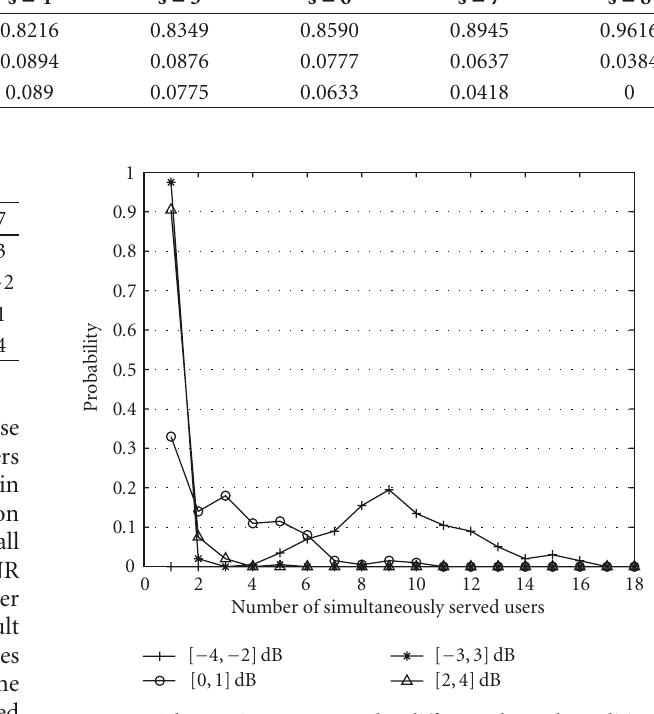
Figure 2: The service pattern under di ff erent channel conditions (i.e., SNRs)